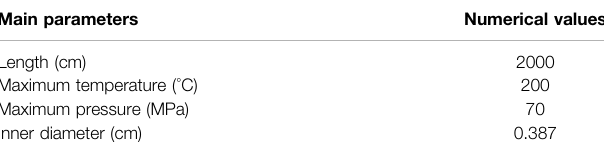
TABLE 2 | Basic parameters of the long-slim-tube displacement experimental